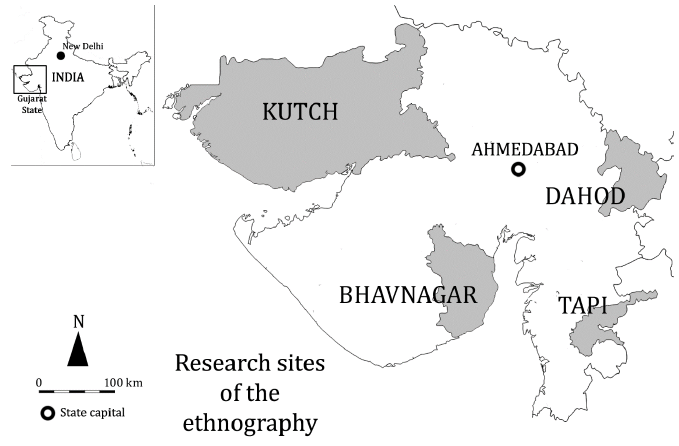
Fig 1. Research Sites of the